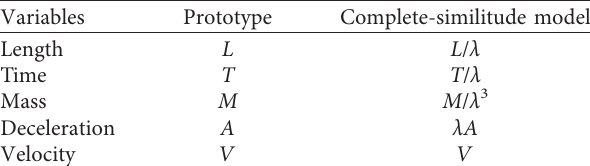
Table 1: Scaling factors of the small-scale model and prototype.